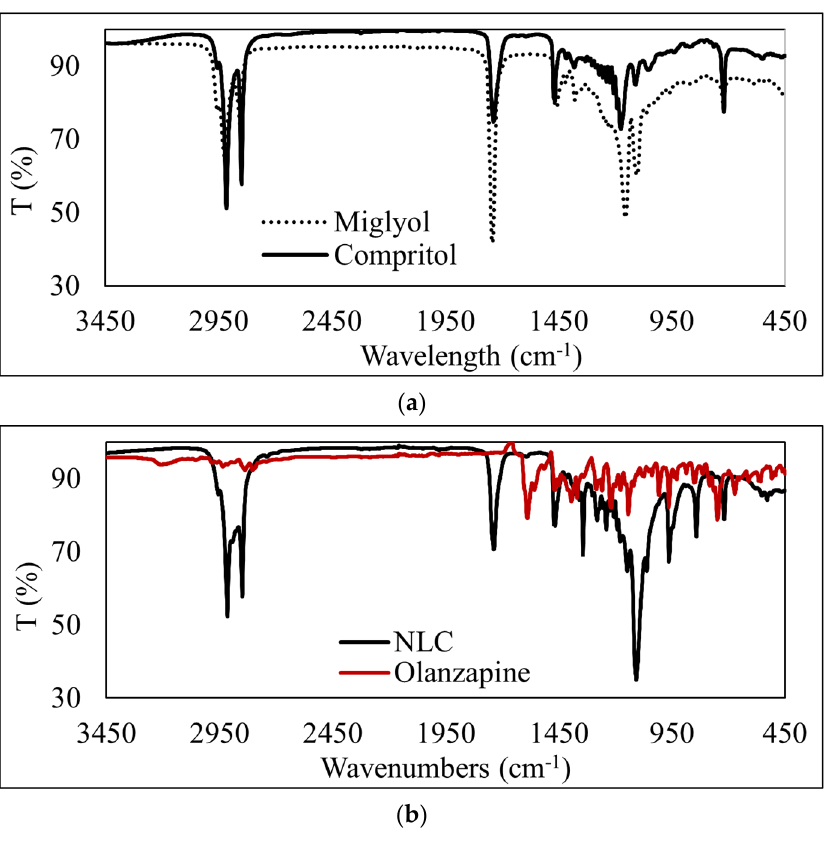
Figure 7. ( a ): ATR-FTIR spectra for Mig and C888. ( b ) ATR-FTIR spectra for NLCs and unpro- cessed OLZ.